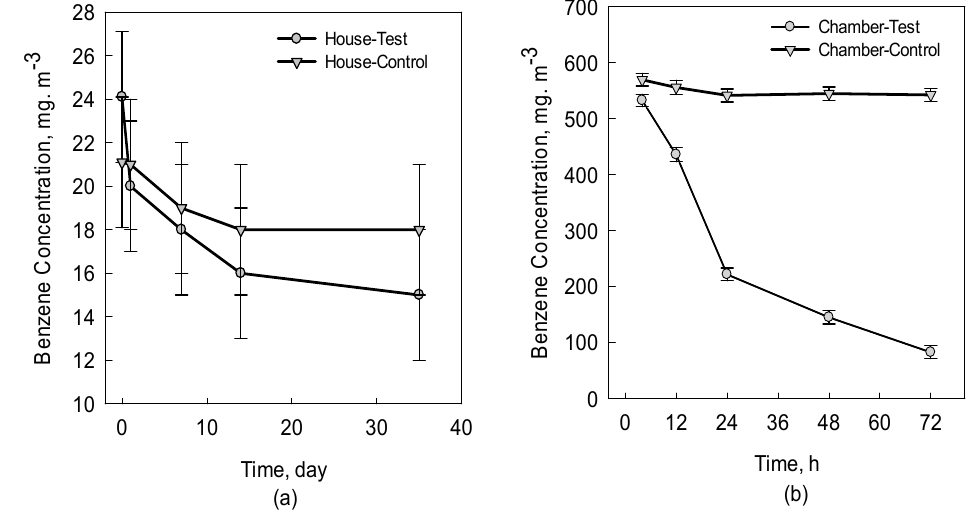
Figure 1. Benzene removal efficiency of Epipremnum aureum in house ( a ) and in chamber ( b ). The error bar indicates the standard deviation for three replicates.